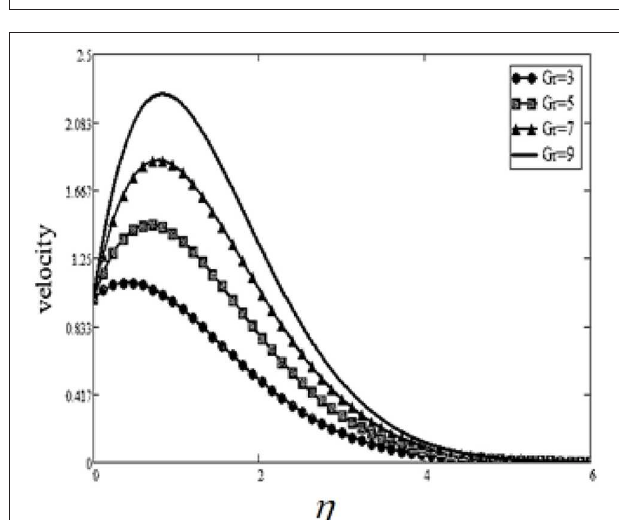
FIGURE 1 | Velocity plot for τ .